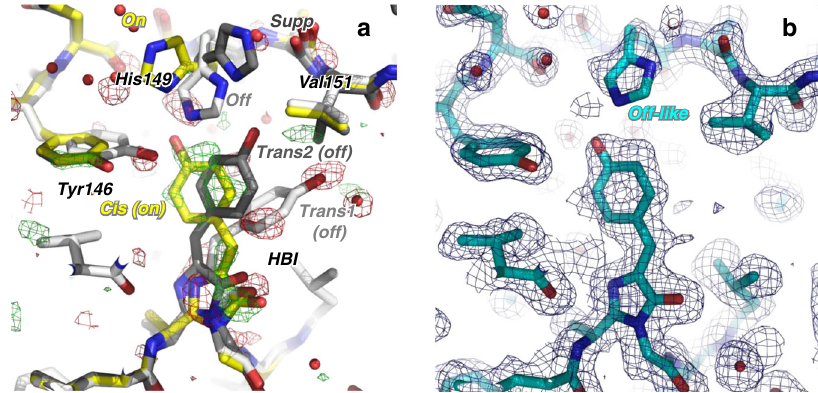
Fig. 4 10-ns intermediate-state structure. a Q-weighted difference electron density map (F obs laser_on_ Δ 10ns – F obs laser_off ), determined from SFX data with and without pump-laser activation, is contoured at + 3 σ (green) and − 3 σ (red) and overlaid onto the model determined from the laser_off dataset. b Model of the laser_on_ Δ 10 ns intermediate structure (cyan) determined by difference re fi nement at 1.85 Å resolution. 2F extrapolated laser_on_ Δ 10ns – F calc (blue, 1 σ ) and F extrapolated laser_on_ Δ 10ns – F calc maps (green/red, ±3 σ , respectively) are laser_off model (Fig. 4a). The strongest features are located at the chromophore and its direct environment. Negative (down to − 5.7 σ ) and positive (up to 4.5 σ ) peaks are observed at the positions of the trans1 and the cis chromophore, respectively, in not observe a negative peak on the trans2 chromophore. Such a negative peak might have vanished by overlay of a nearby positive peak on the cis chromophore (Fig. 4a). Additionally, negative peaks are present on the off-state conformers of Tyr146 ( − 4.2 σ )